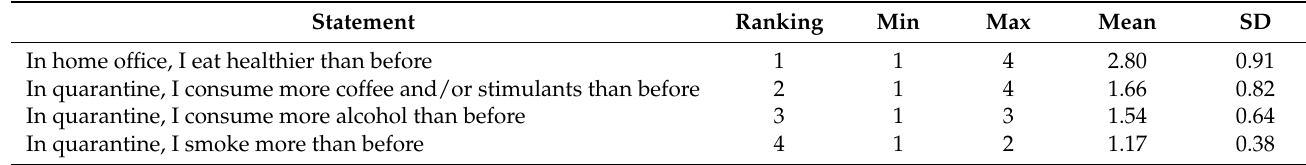
Table 1. Nutrition and substance use during quarantine (N =